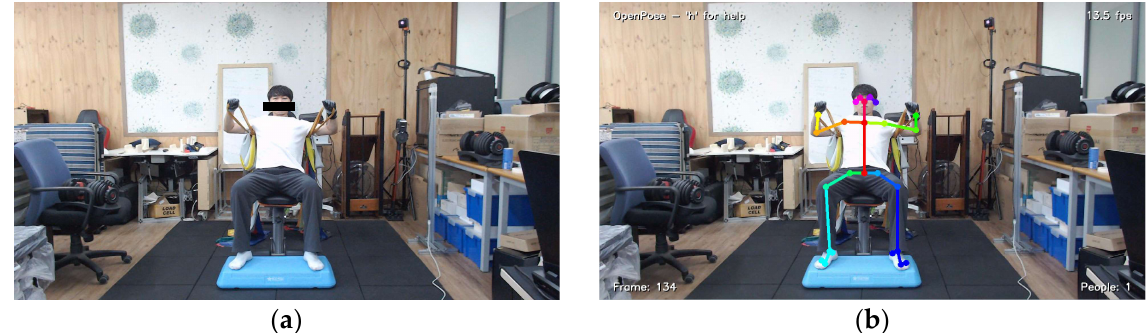
Figure 4. ( a ) Raw RGB video captured by the camera; ( b ) estimated joint position rendered using OpenPose.